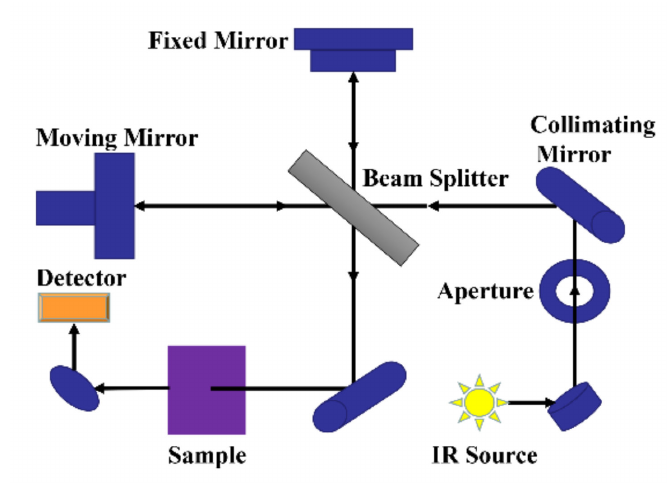
Figure 1. Schematic diagram of the optical system of the mid-infrared